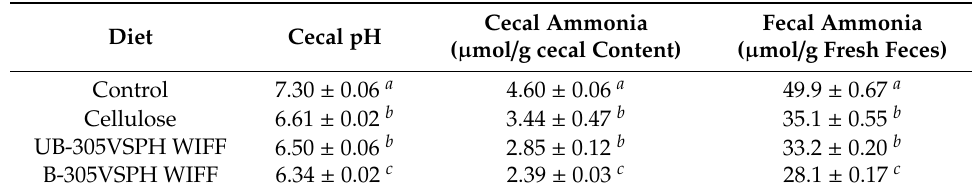
Table 5. Cecal pH values, cecal ammonia, and fecal ammonia of hamsters fed diets with cellulose or WIFF of the UB-305VSPH and B-305VSPH varieties. Diet Cecal